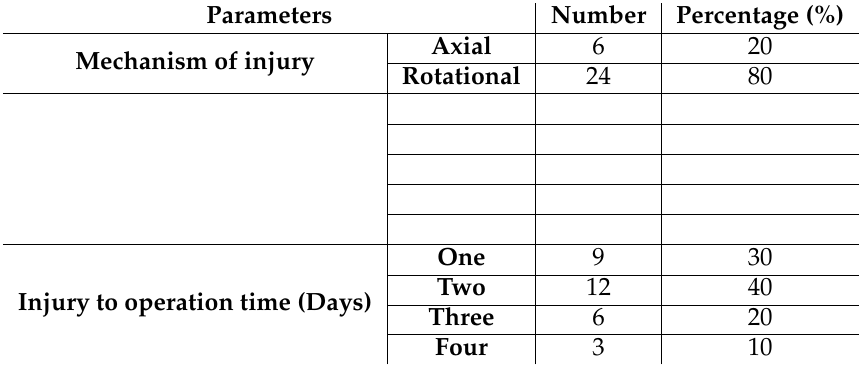
Table 2. Distribution of study subjects according to mechanism of injury, associate injury and injury to operation time Parameters